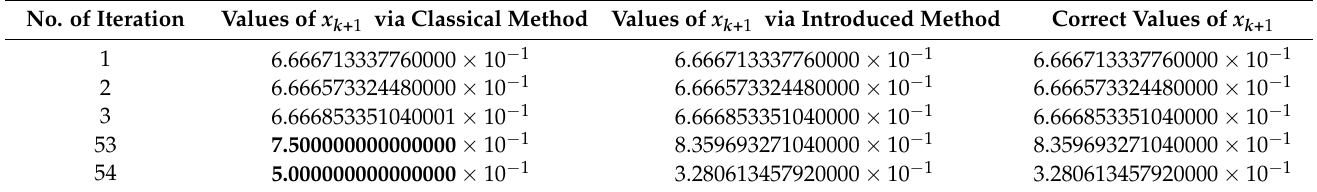
Table 2. Comparative results of the introduced method for the folded Baker’s map. No. of Iteration Values of x k + 1 via Classical Method Values of x k + 1 via Introduced